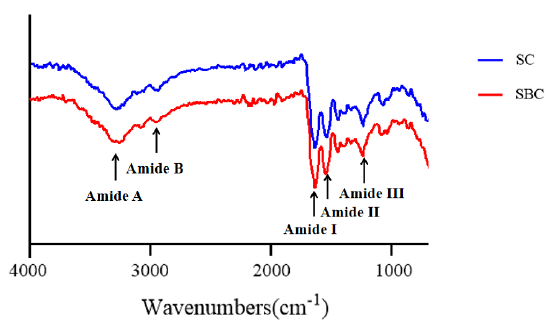
Figure 6 . FTIR spectra of C. idella skin collagen (SC) and swim bladder collagen (SBC). Figure 6. FTIR spectra of C. idella skin collagen (SC) and swim bladder collagen (SBC).